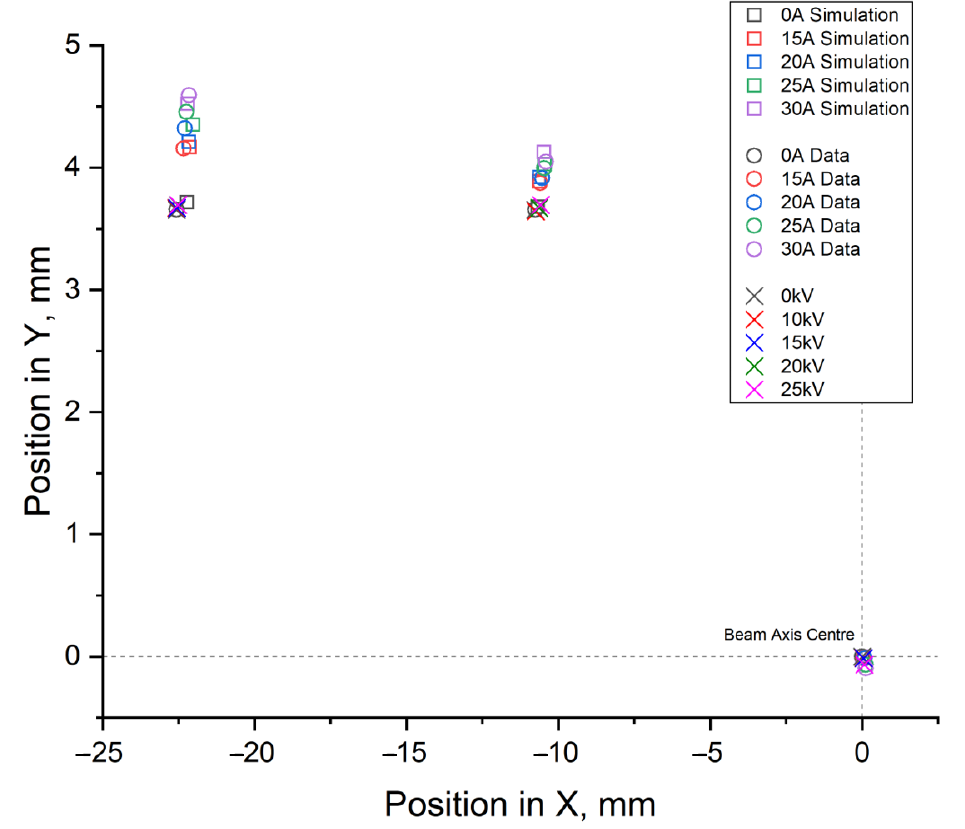
Figure 14. Position of the centroid of the 3 beam spots for varying magnetic fields and high voltages. Squares and Circles represent variation in current through the magnetic coils only, in simulation and data respectively, with no applied high voltage. Crosses represent variation in high voltage (and therefore electric field) with no current through the magnetic